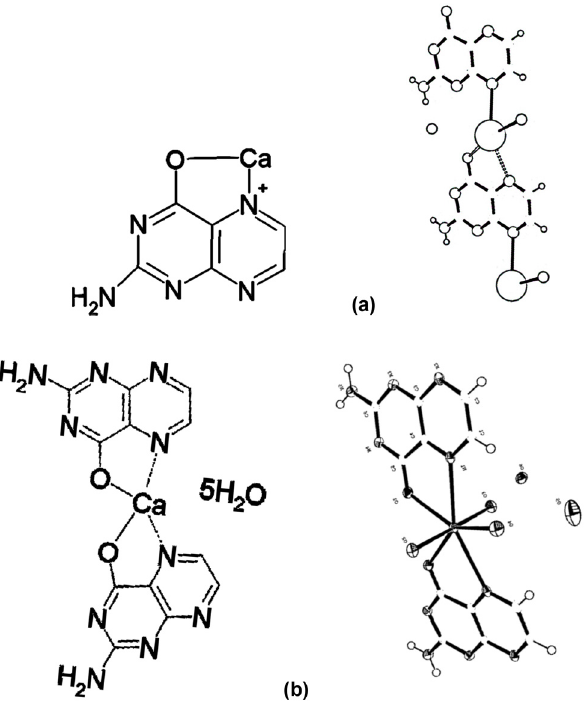
Figure 2: X - Ray crystallographic structure: ( a ) CaPterin and ( b ) dipterinyl calcium pentahydrate ( DCP ) [ 9 ]